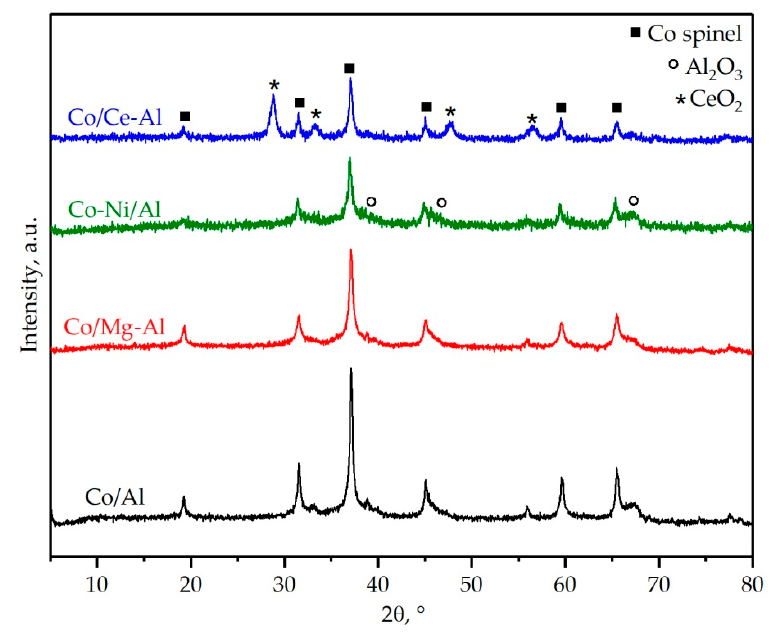
Figure 3. XRD patterns of the supported cobalt catalysts.